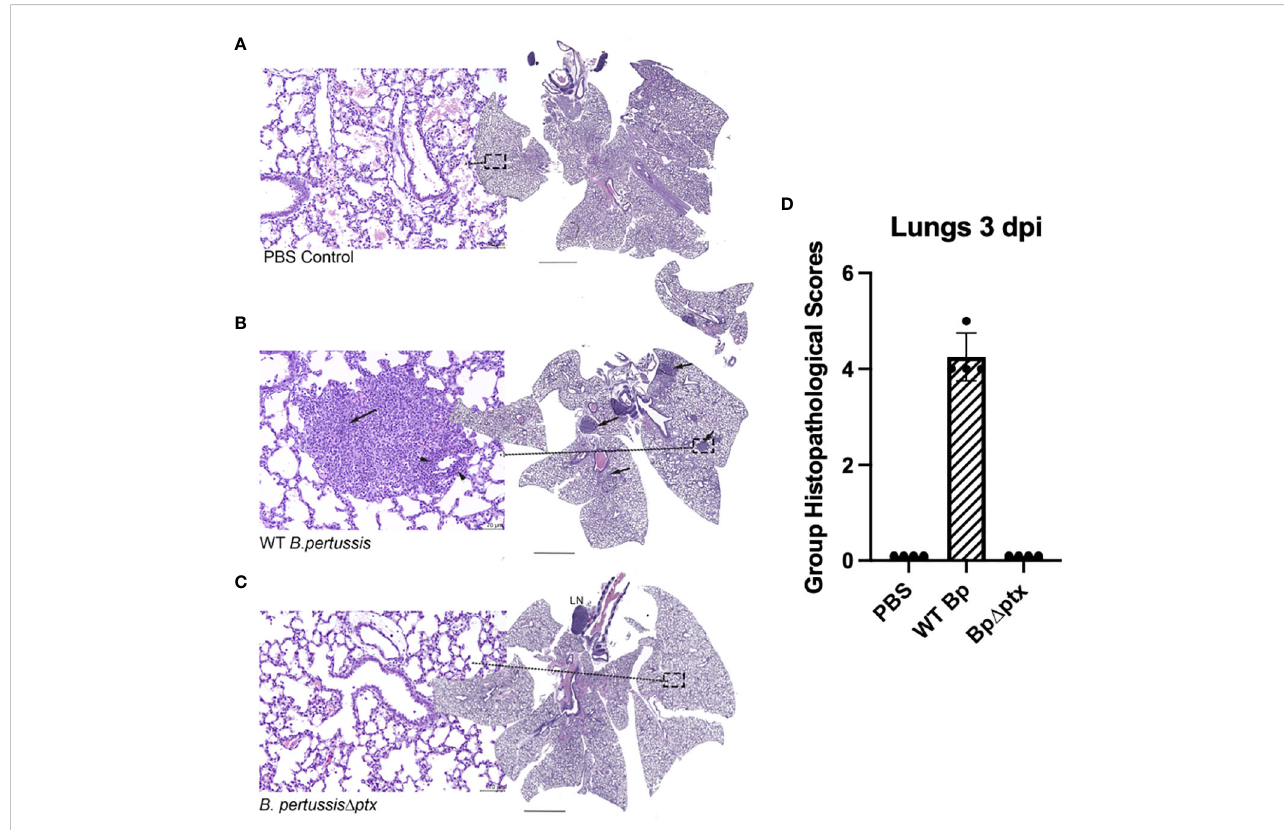
FIGURE 5 Pertussis toxin affects in fl ammation in the lungs of neonatal C57BL/6J mice. Representative images from neonatal lung mice exposed to PBS, WT Bp , or Bp D ptx at 3 dpi. (A) PBS treated control. The center image is a whole-slide image from the lung. HE stain. Scale bar = 1.2 m m. The left image represents higher magni fi cation (dashed box) of the lung. There are no signi fi cant tissue alterations. HE stain. Scale bar = 70 m m. (B) Middle panel : WT B . pertussis . The center image is a whole-slide image from the lung, with multiple hypercellular foci (arrows). HE stain. Scale bar = 1.2 m m. The left image represents higher magni fi cation (dashed box) of the lung, with large number of neutrophilic and macrophage in fi ltrates obscuring the alveoli (arrow), and mild number of lymphocytes expanding the perivascular tissues (arrow heads). HE stain. Scale bar = 70 m m. (C) B . pertussis D ptx . The center image is a whole- slide image from the lung, with a distinct tracheobronchial lymph node (LN). HE stain. Scale bar = 1.2 m m. The left image represents higher magni fi cation (dashed box) of the lung. There are no signi fi cant tissue alterations and resemble the lung tissues from PBS control mice. HE stain. Scale bar = 70 m m. (D) Group Histopathological Scores . In the current fi gure, Group Histopathological Scores, which were calculated by adding individual animal severity + distribution scores, were highest for the WT B . pertussis treated group at 3 dpi. The scores for the B . pertussis D ptx and PBS treated control groups were similar (Supplementary Table